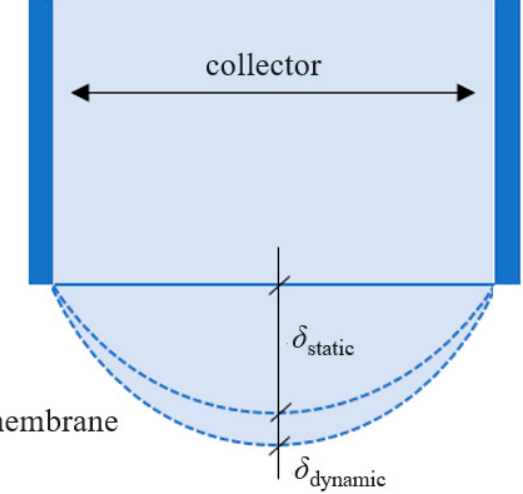
Figure 8. Membrane deformation under static pressure and dynamic pressure.